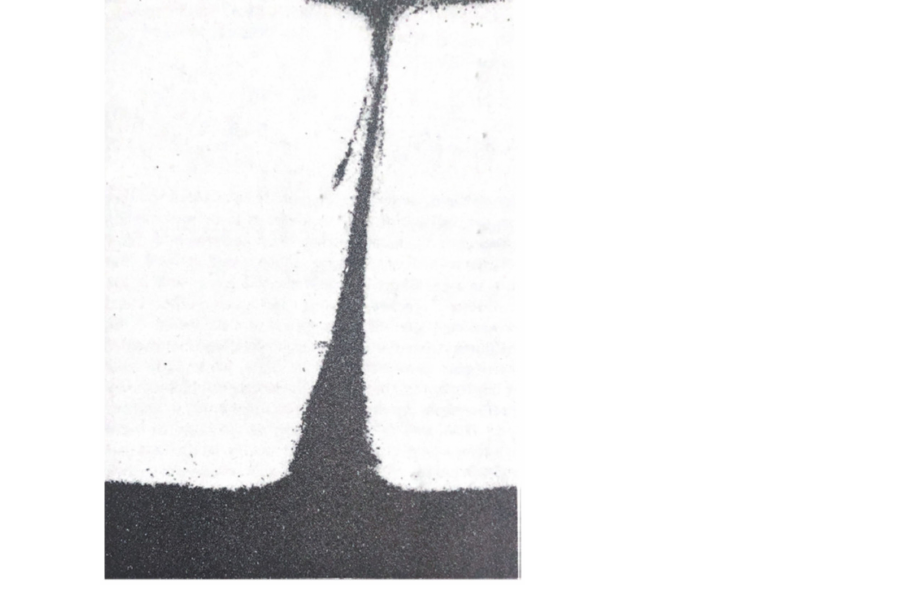
Figure 2. Displacement caused by a single rising bubble through a three-dimensional bed